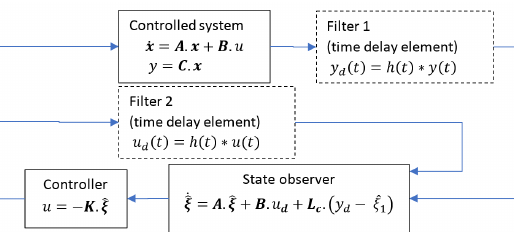
Figure 5. Block diagram of the sensor/state observer/state feedback controller scheme. This includes time-delay element 1 (low pass filter), which is an integral part of sensor preamplifier electronics. In order to provide a causal relationship between force and deflection information entering the state observer, a second time delay element identical to time delay element 1 is introduced. Here, the function h ( t ) denotes the impulse response of the filter and the asterisk denotes the convolution integral. This scheme is used to evaluate the stability of the feedback